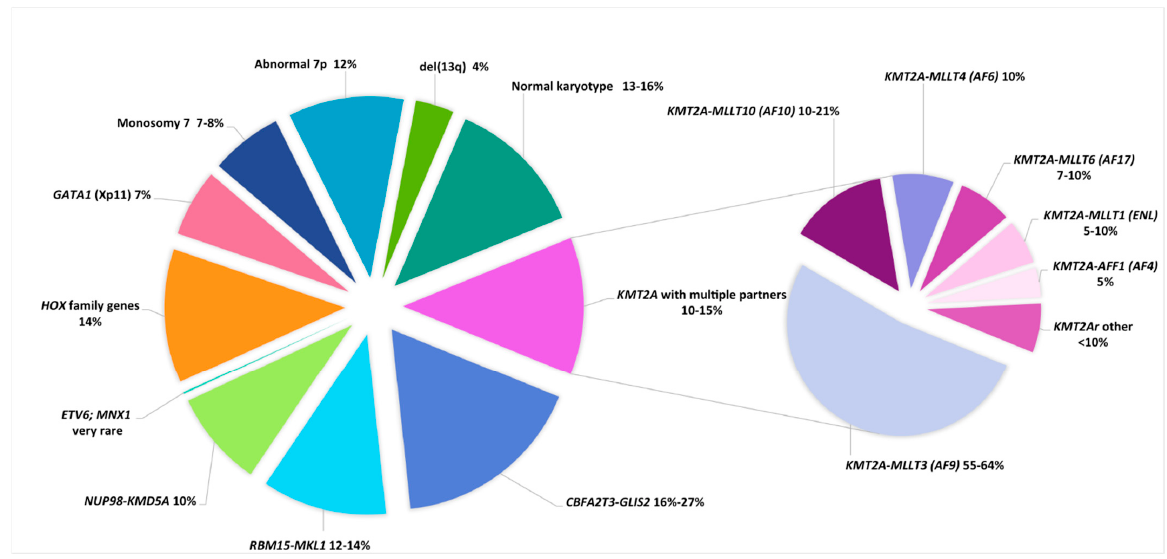
Figure 2. Distribution of cytogenetic subgroups in non-DS pediatric AMKL (adapted from De Rooij 2017 [63] and Masetti 2019 [65]. Table 3. Pediatric and Adult AML cytogenomic risk stratification according to and adapted from Creutzig et al. [1] and Döhner et al. [21], respectively.